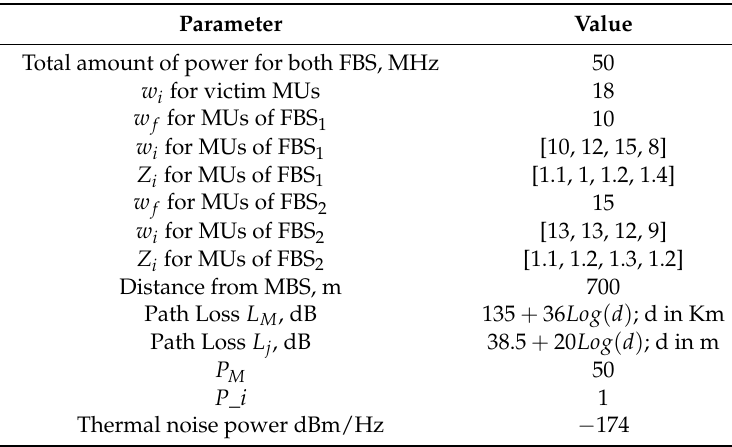
Table 1. Simulation